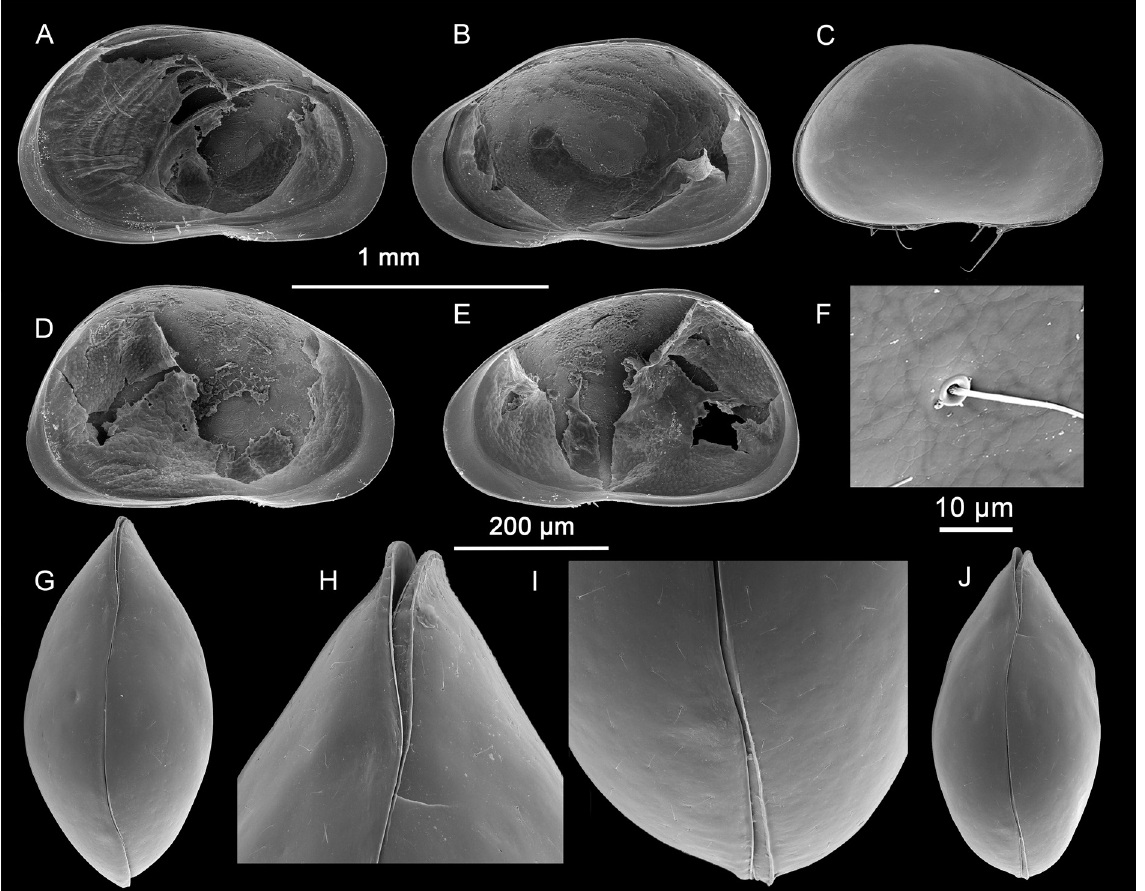
Fig. 2. Patcypris outback gen. et sp. nov., Lake Maitland (type locality). A . LVi, ♂, holotype (WAM 67184). B . RVi, ♂, holotype (WAM 67184). C . CpRL, ♂, paratype, small specimen (WAM